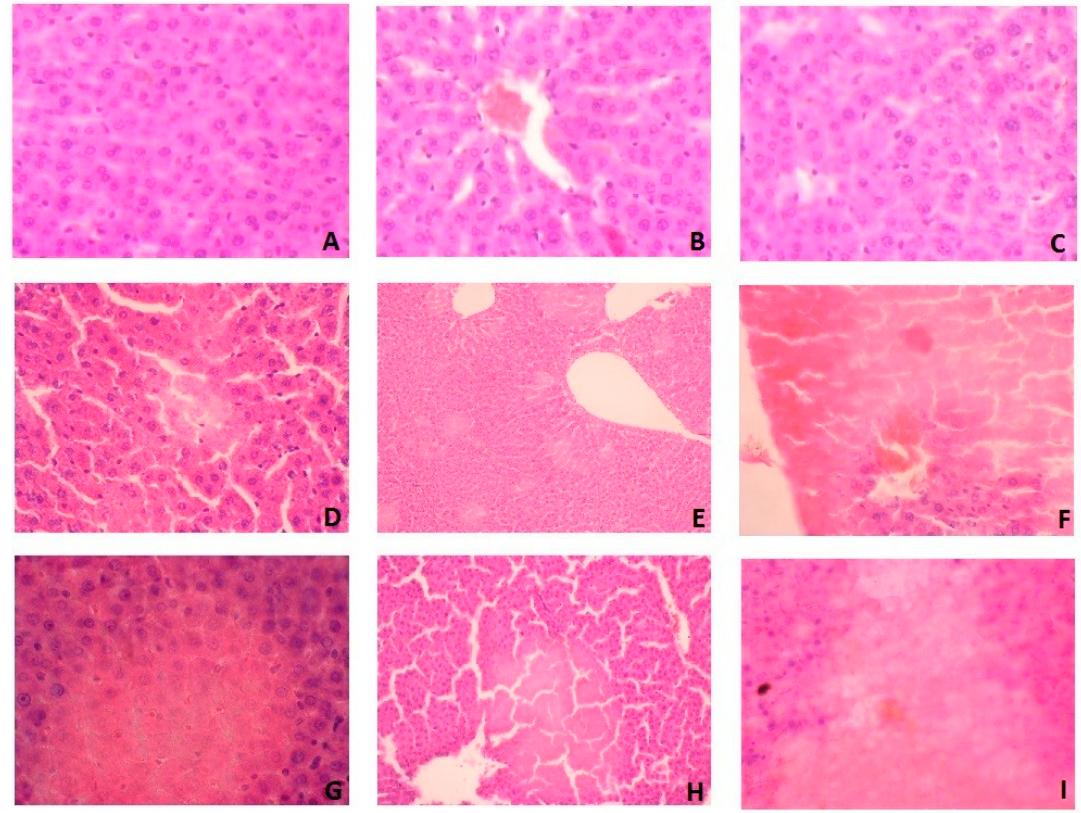
Figure 7. Liver histological examination of WPC-80-fed rats and the control group. A (C7), B (C14), C (C21), D (0.3 WPC 7), E (0.3 WPC 14), F (0.3 WPC 21), G (0.5 WPC 7), H (0.5 WPC 14), I (0.5 WPC 21).